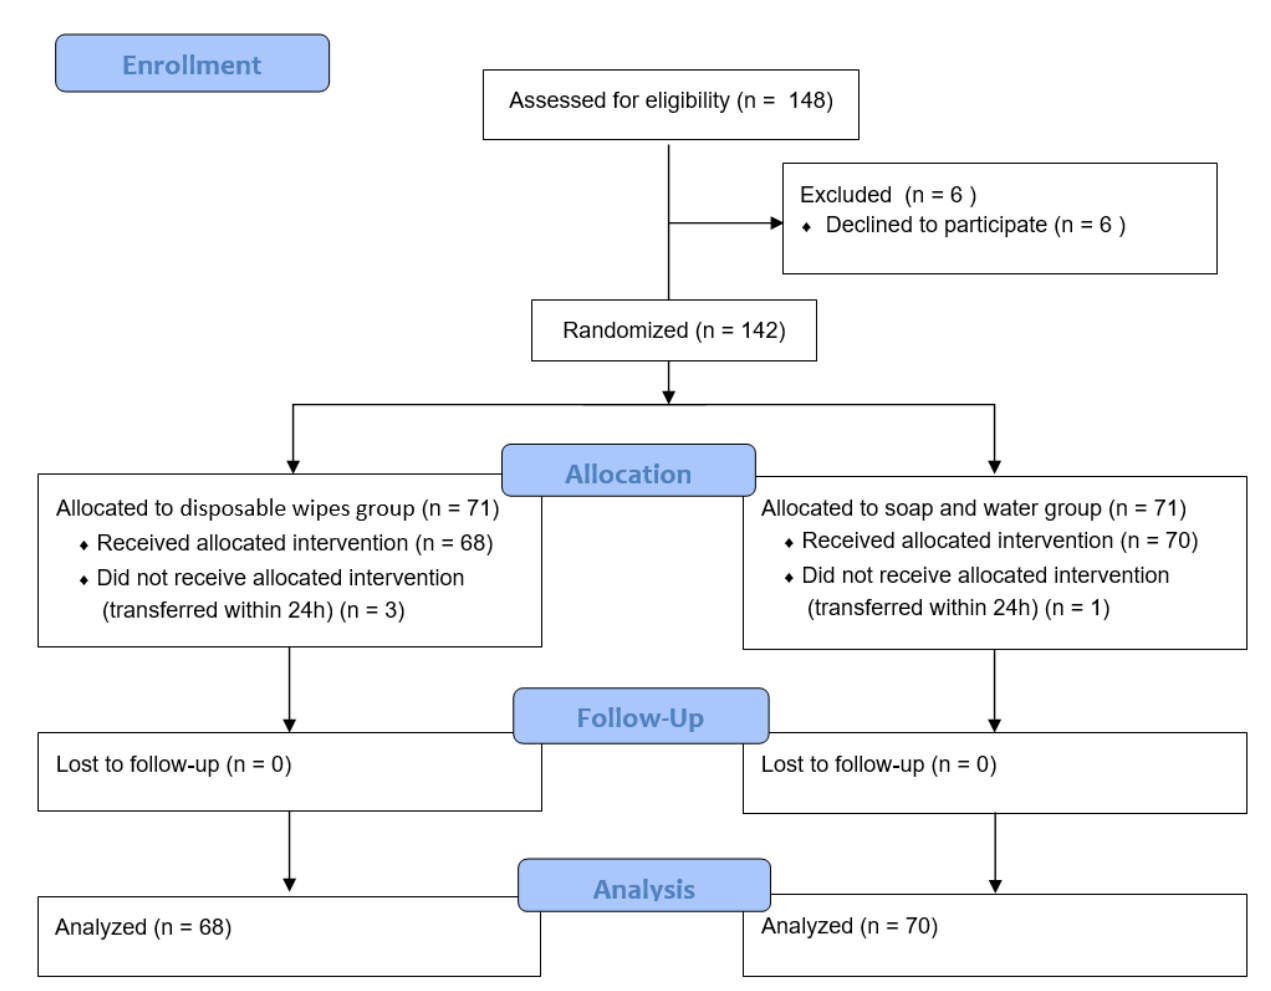
Figure 1. Enrollment process. Table 1. Comparison of the participants’ general characteristics.